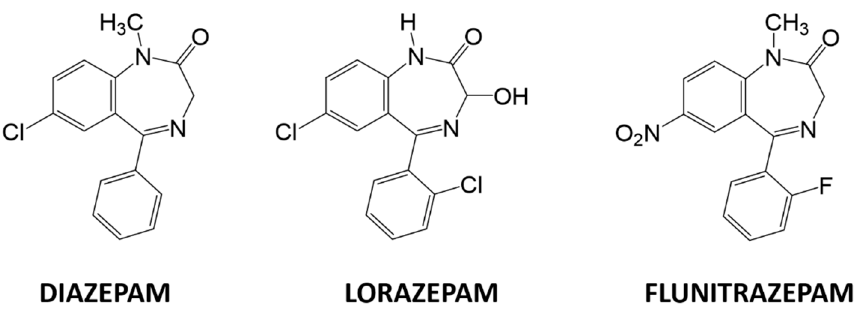
Figure 1. Chemical structures of diazepam, lorazepam, and flunitrazepam.